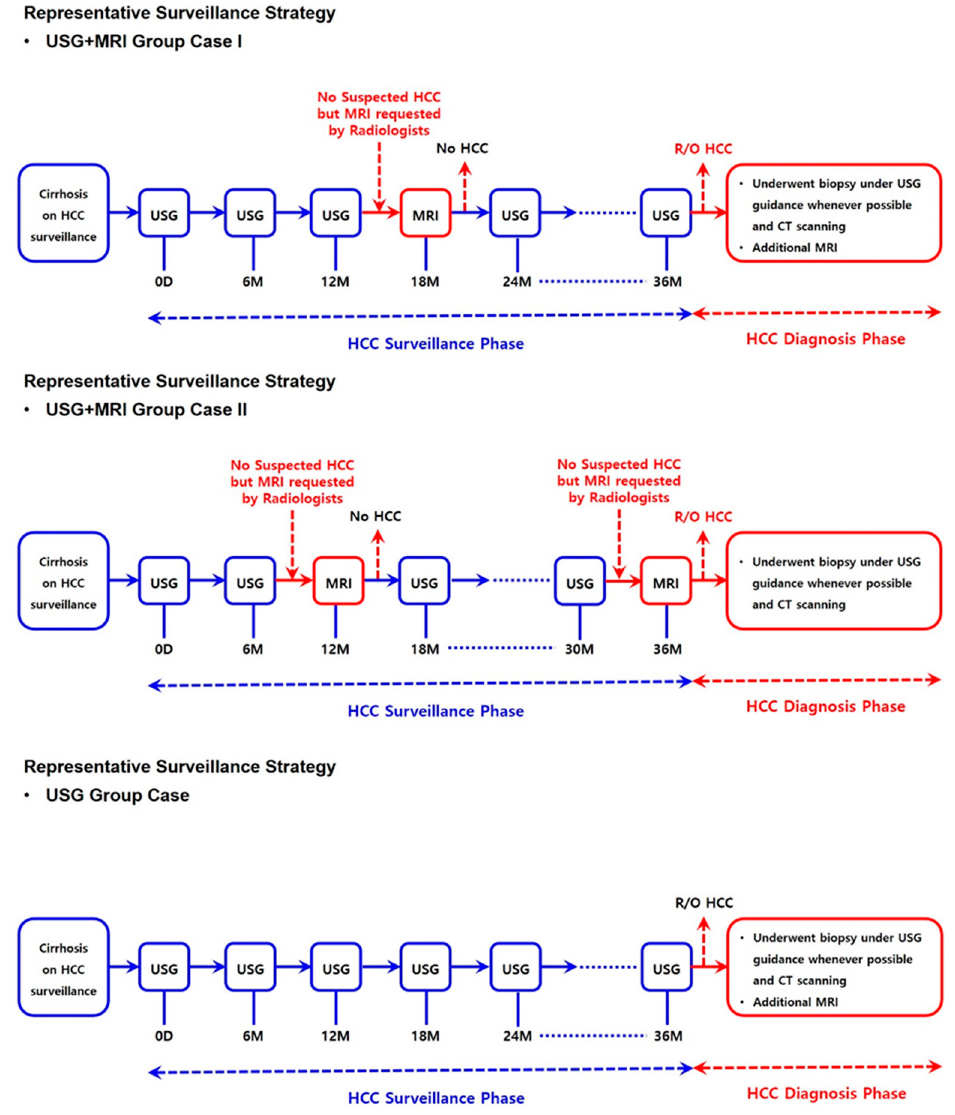
Figure 1. Representative surveillance strategy of each group. (USG, ultrasound; HCC, hepatocellular carcinoma; MRI, magnetic resonance imaging; CT, computed tomography).